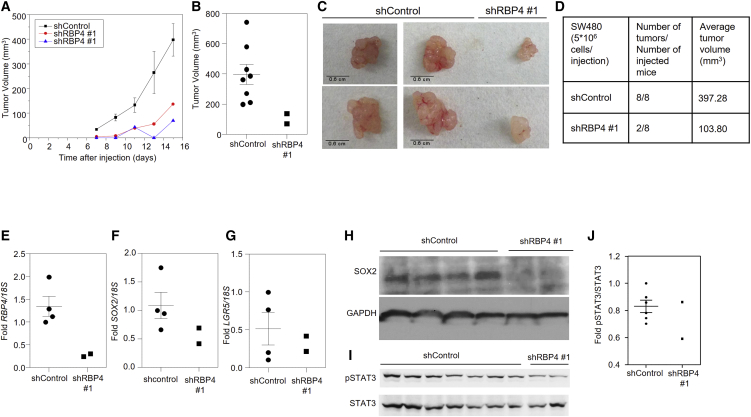
RBP4 Drives Tumor Survival of SW480 Cells(A) Tumor growth in athymic NCr mice injected with SW480 cells (5 × 106) stably expressing non-target or RBP4 shRNA. Data for control tumors are mean ± SE (n = 8 tumors).(B) Tumor volumes of individual tumor at 15 days after injection are plotted. Mean (n = 8 tumors) and SE for the control are shown.(C) Representative tumors are shown that originate from SW480 cells stably expressing control or RBP4 shRNA.(D) Average tumor volume at experimental endpoint and number of tumors initiated in each group are shown in the table.(E–G) Levels of RBP4 (E), SOX2 (F), and LGR5 (G) mRNAs in SW480 tumors. Mean and SE for the control samples (n = 4 tumors) are shown.(H) Immunoblots showing levels of SOX2 and GAPDH.(I) Immunoblot showing levels of p-STAT3 and total STAT3 in SW480.(J) Immunoblots in (I) were quantified using ImageJ software, and fold changes are presented. Mean and SEs for the control samples (n = 4 tumors) are shown.